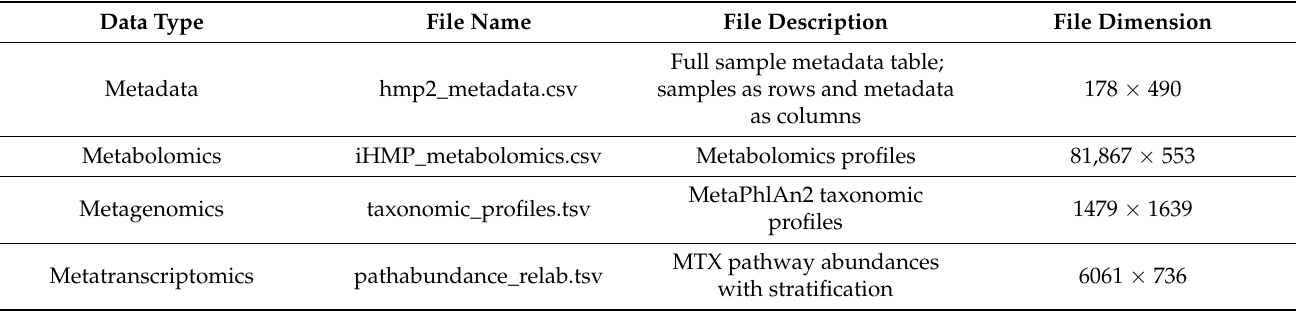
Table 3. Structure of data files used in the present study from the Human Microbiome Project II–IBD study